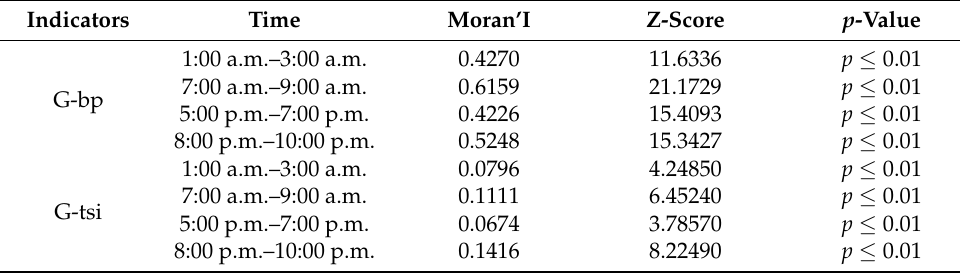
Table 5. Spatial autocorrelation analysis of indicators within each period.